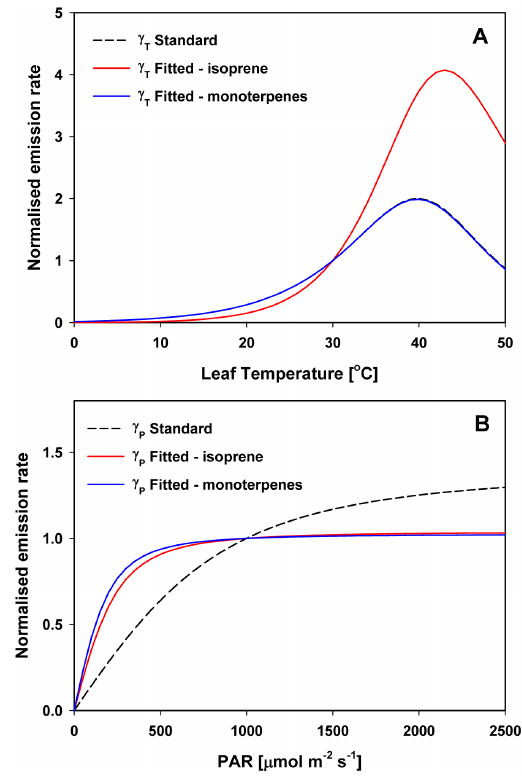
Fig. 9. The temperature (A) and light (B) response of the G06 al- gorithm. Dashed lines show the G06 response using standard co- efficients which are based on temperate species only (in (A), the dashed line is directly below the blue line). Solid lines show the G06 response for isoprene (red) and monoterpenes (blue) using new coefficients which were obtained by fitting the algorithm response to measured fluxes above a tropical rainforest in Malaysian Bor- neo. In each response, past light and temperature values were set to: T24=297, T240=297, PAR24=360, PAR